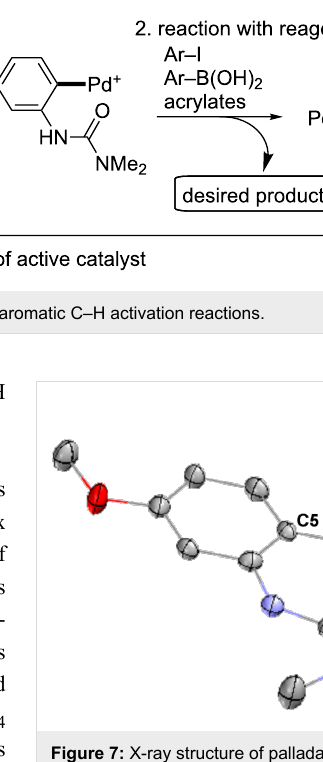
Figure 7: X-ray structure of palladacycle 6 with thermal ellipsoids at the 50% probability level. BF 4 and hydrogen atoms were omitted for clarity. Selected bond length (Å): Pd–C(5) = 1.980, Pd–N(3) = 1.995, Pd–N(4) = 2.126, Pd–O(2) = 1.988. Selected angles